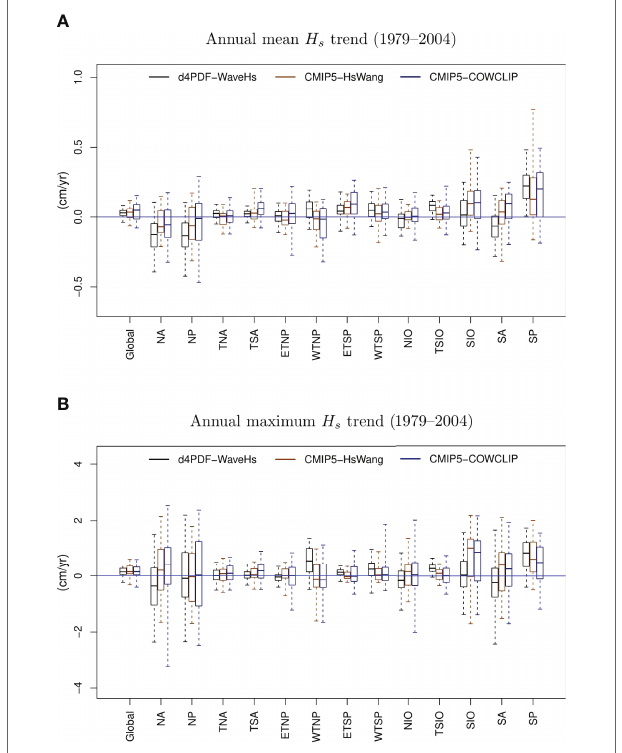
FIGURE 6 | Ensemble average of the regional trend (cm/yr) of the annual mean (A) and maximum (B) H s averaged over the indicated areas (see Figure 1 ) as derived from d4PDF-WaveHs (black), CMIP5-HsWang (brown) and CMIP5-COWCLIP (dark blue) for the 1979–2005 (see Section 2). Box plot illustrates the 2.5%, 25%, 50%, 75% and 97.5%